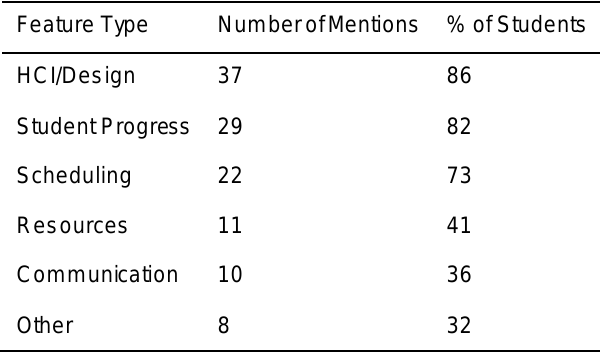
Table 1. Features (grouped during thematic analysis) proposed by students (n=22) for an LA